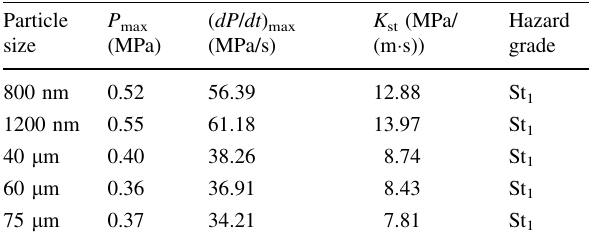
Table 3 Micro-nano coal dust explosion characteristics and risk